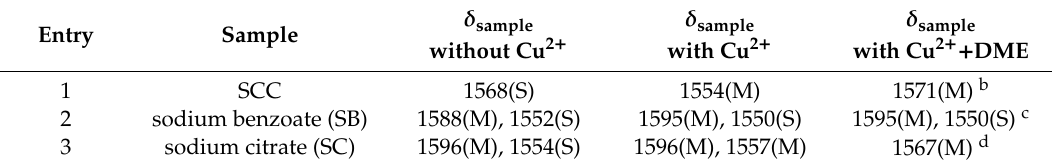
Table 3. FT-IR vibration wavenumbers (cm − 1 ) for the carboxylate groups of SCC, SB, and SC with or without Cu(ClO 4 ) 2 and DME a